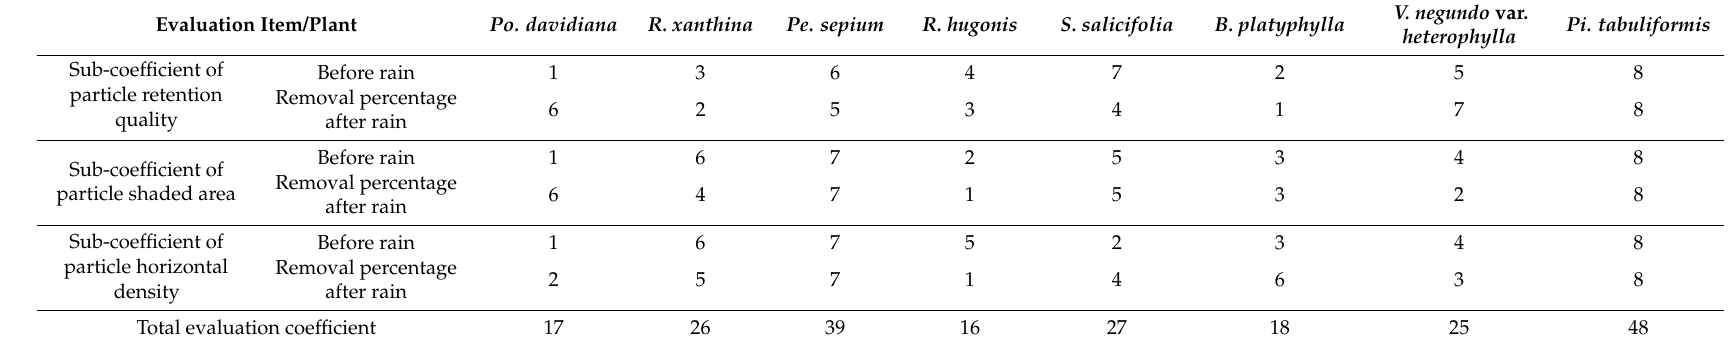
Table 1. Evaluation results for the purification capacity coefficient of atmospheric particulate pollutants by the main plants in the Mount Wutai scenic area. Evaluation